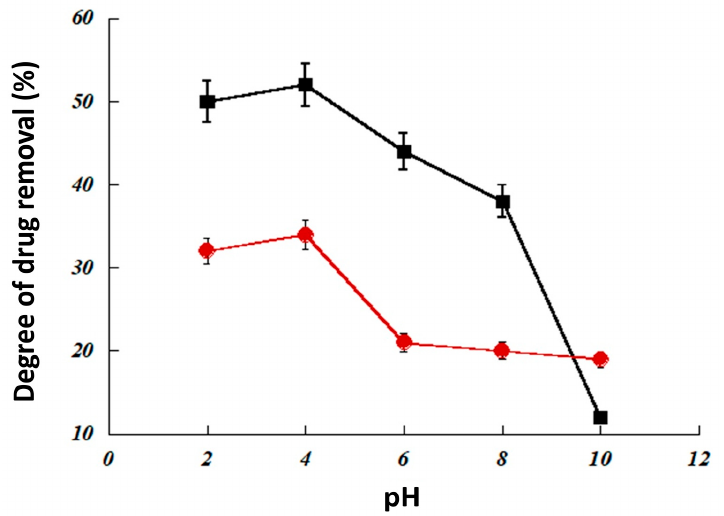
Figure 9. Influence of pH on extraction of residual drug in wastewater. Two drugs were tested at an initial concentration of 10 ppm: ibuprofen (red circles) and progesterone (black squares). The extraction process was performed over 6 h. Each essay was performed in triplicate.